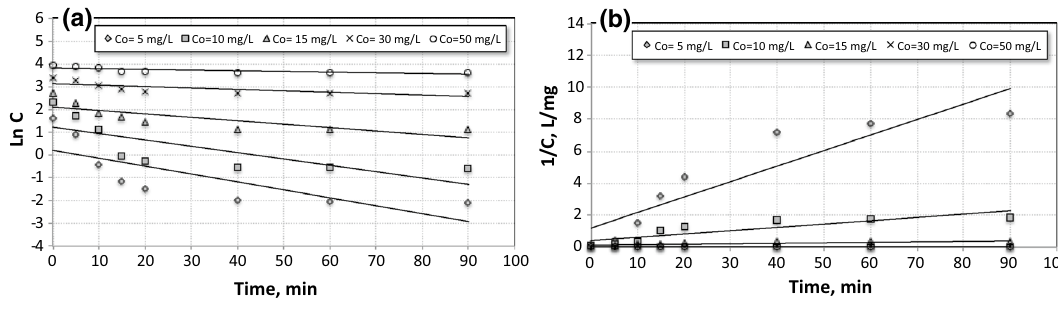
Fig. 9 Kinetic plots for photodegradation of MB using ZnO NPs a first-order plots, b second-order plots Table 5 Data of the first- and Concentration, First-order reaction Second-order kinetics % second-order reaction kinetics mg/L